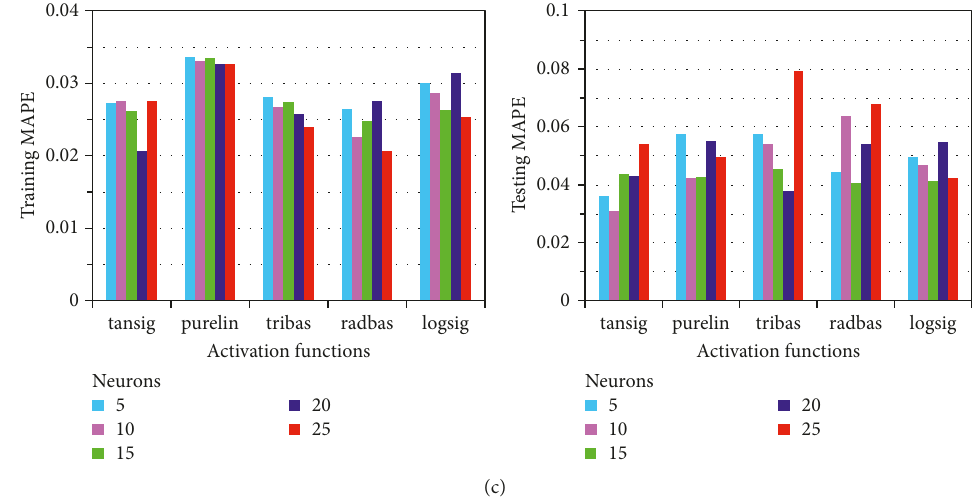
Figure 7: (a) RMSE, (b) MAE, and (c) MAPE performances of training and testing phases for specific